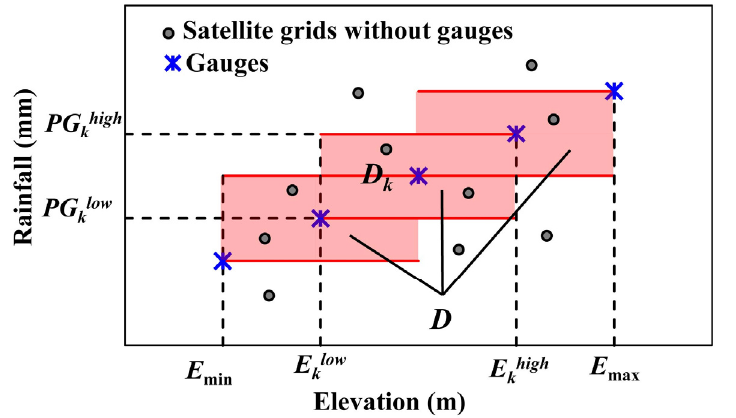
Figure 1. The derivation of rainfall-elevation mask ( l = 3, M = 5). The red solid lines are the up and low limit of rainfall and the black dashed lines are the up and low limit of elevation of each sub-mask. The whole pink region is the final rainfall-elevation mask